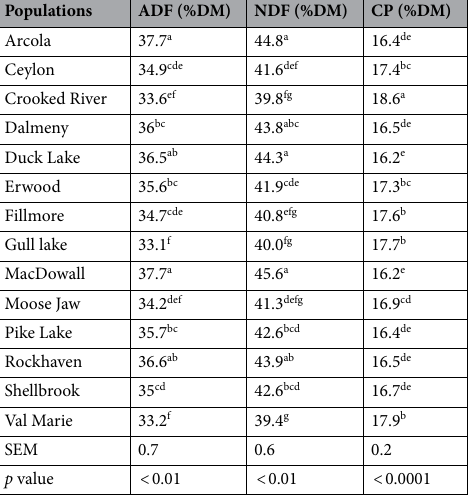
Table 3. Mean comparison of three nutritive value traits of 14 alfalfa populations with long-term grazing history from 2018 to 2019 at the Agriculture and Agri-Food Canada Saskatoon Research Farm, SK, Canada. Note: The different lowercase letters within a column are significantly different according to Tukey’s HSD at p ≤ 0.05. SEM, standard error of the mean.